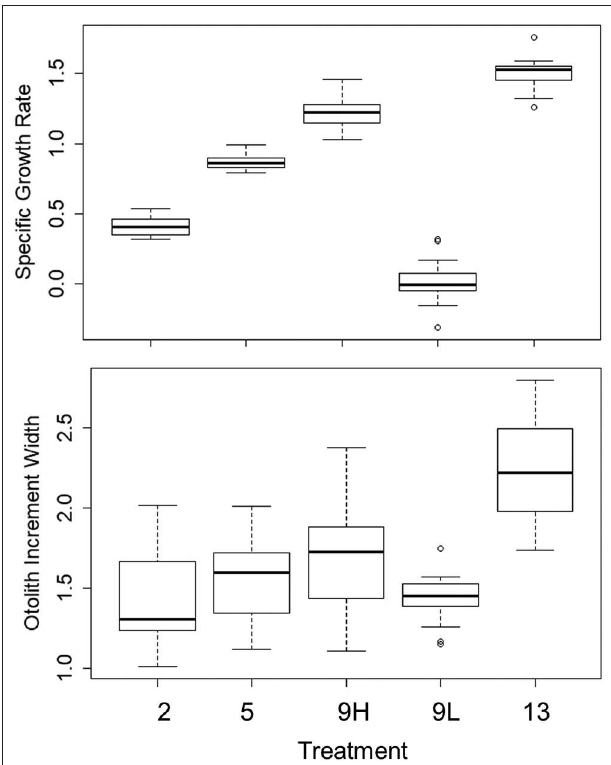
FIGURE 2 | Median, first, and third quartiles and outlying points for specific growth rate (% body mass d − 1 ) and otolith increment width ( µ m) during the experiment for the 2, 5, 9_low, 9_high, and 13 ◦ C